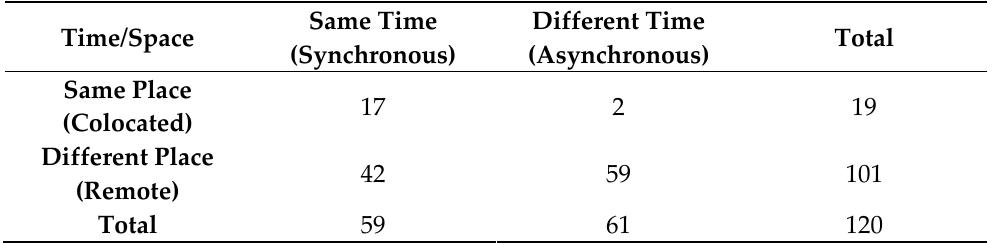
Table 1. Frequency of groupware matrix categories.